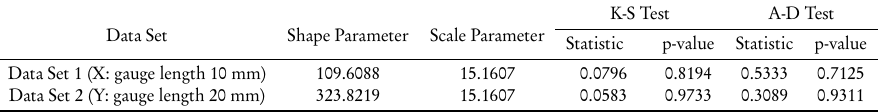
MLEs, K-S and A-D tests for real data sets assuming common scale